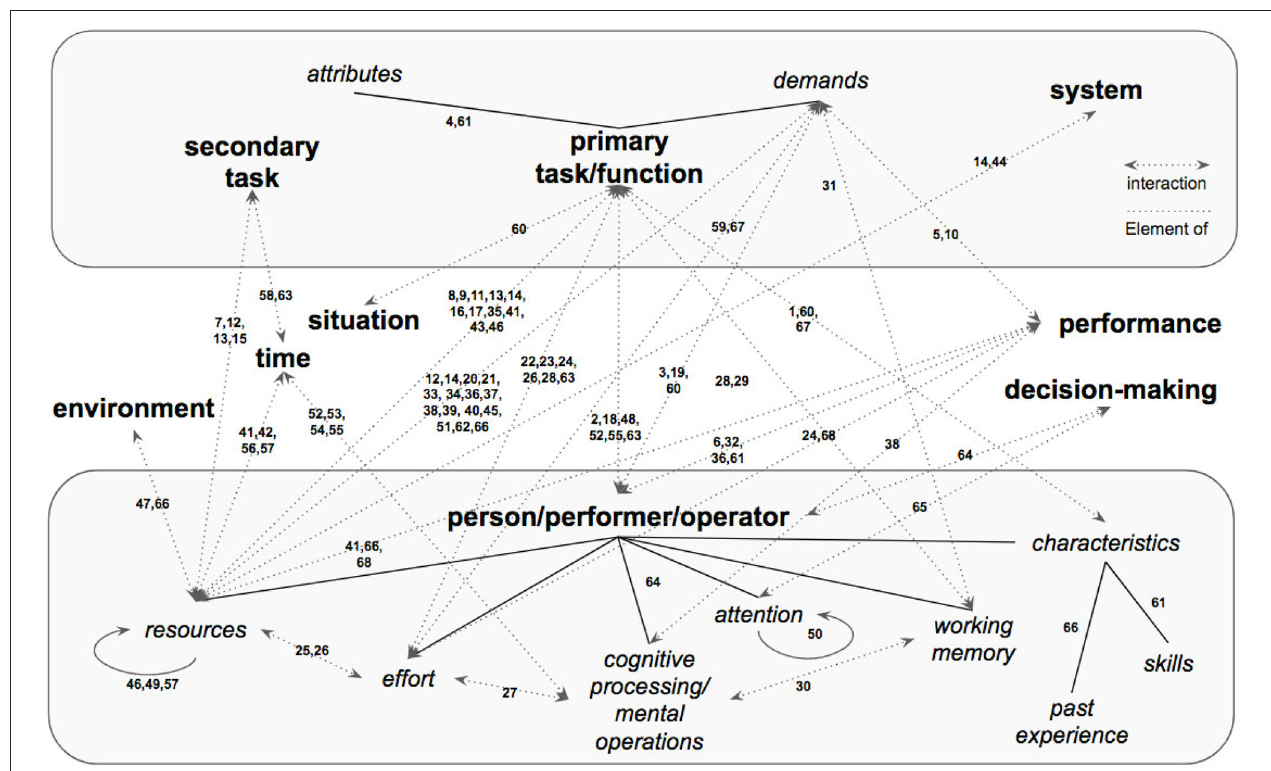
FIGURE 9 | Synthesis of the main concepts, sub-concepts and their interaction associated with the definitions of mental workload found in the literature. The numbers on top of each arrow refers to one or more definitions in Table 2 in Appendix